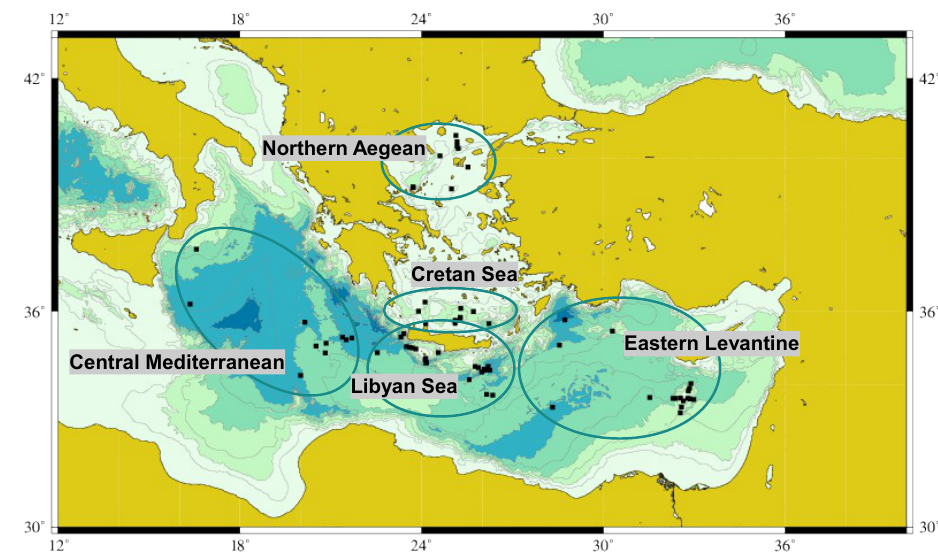
Fig. 1. Study areas and sampling stations along the Mediterranean